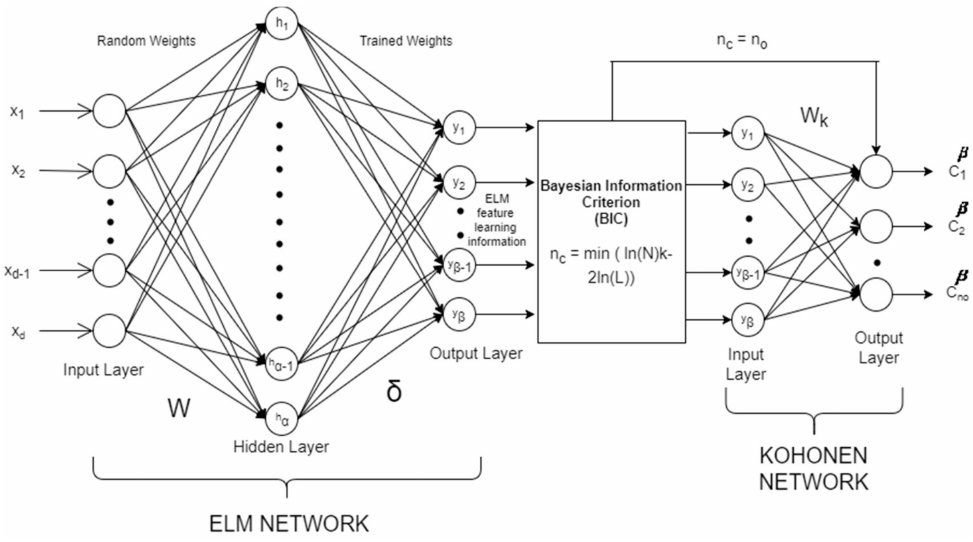
Figure 1. BELMKN